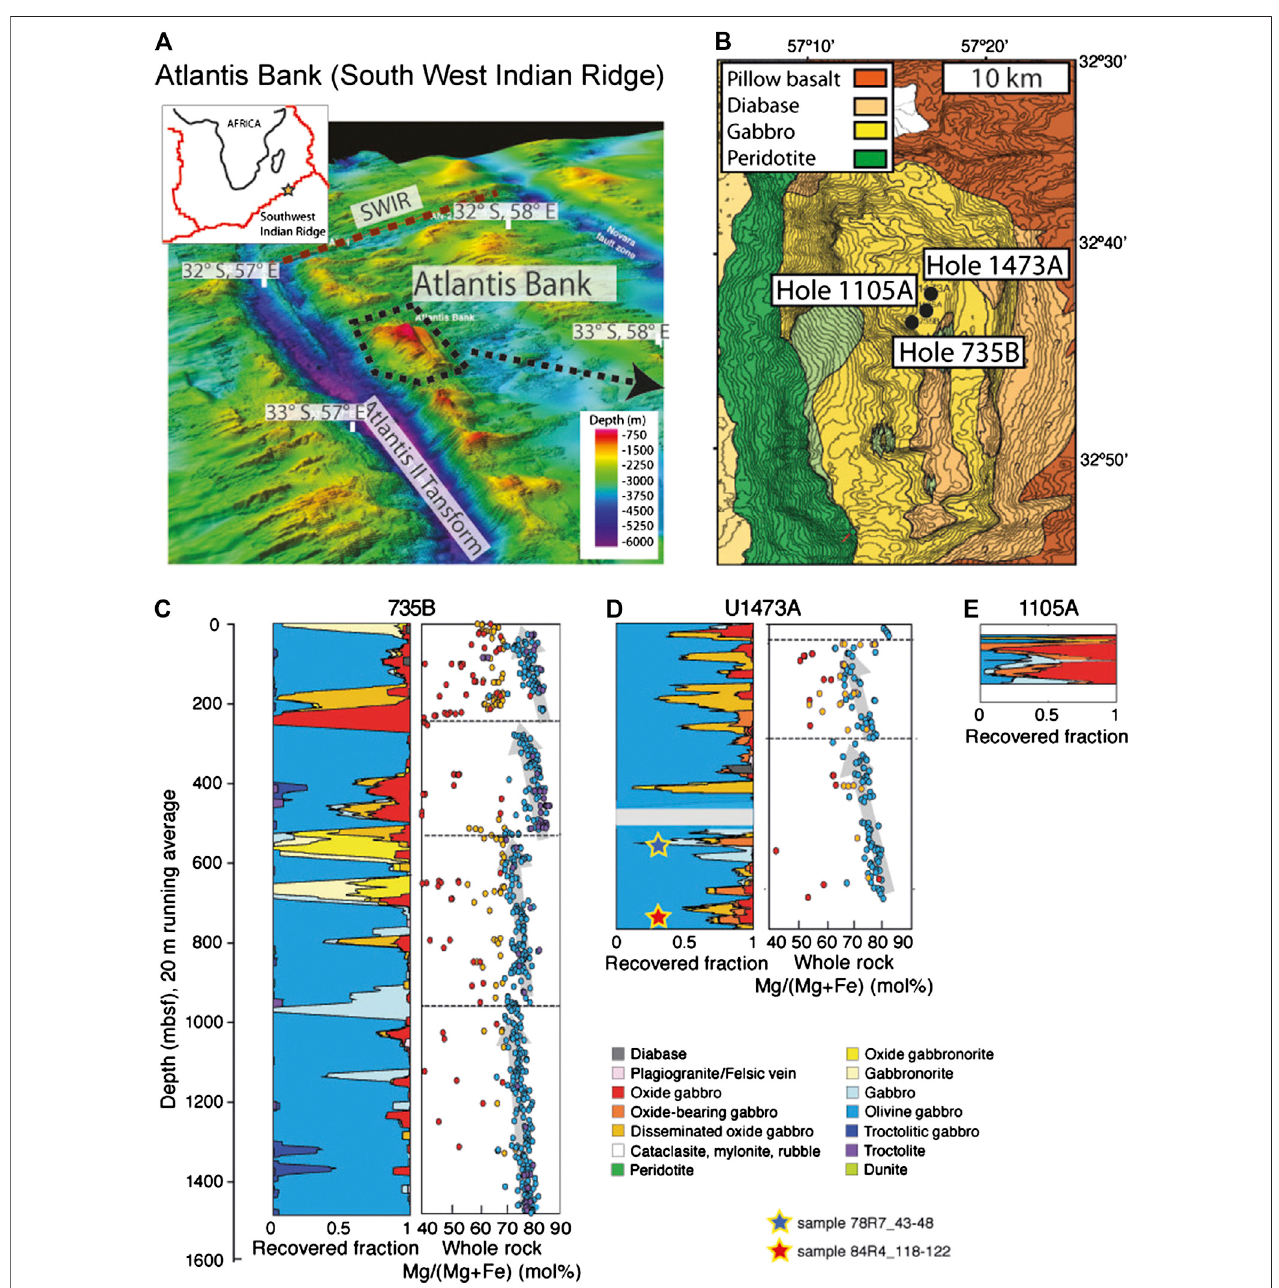
FIGURE 1 | (A) Location and bathymetric map of the Atlantis II Fracture Zone in the Southwest Indian Ridge and (B) and detail of the Atlantis Bank core complex showing the location of Holes 1105A, 735B and U1437A (C) Stratigraphic columns representing running averages of lithological intervals plotted against depth in Holes 735B, U1473A and 1105A. Whole rock Mg/(Mg + Fe) (mol%) compositions of samples from Hole 735B and U1473A are also reported, de fi ning distinct geochemical units (modi fi ed from MacLeod et al., 2017). The location of samples U1473A-78R-7_43 – 48 and U1473A-84-R4_118 – 122 is also